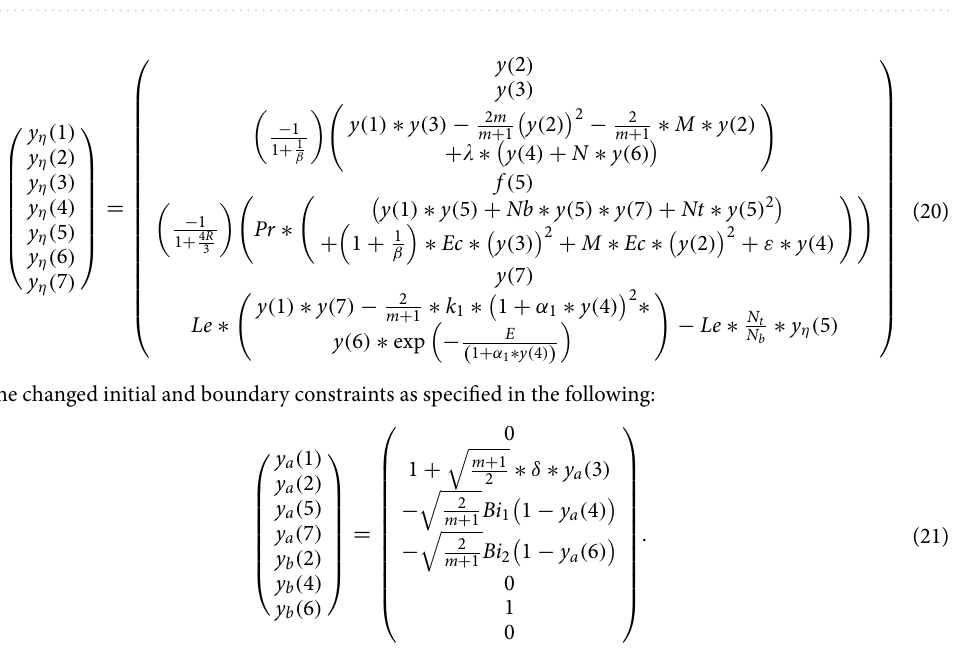
Figure 2. The steps of numerical